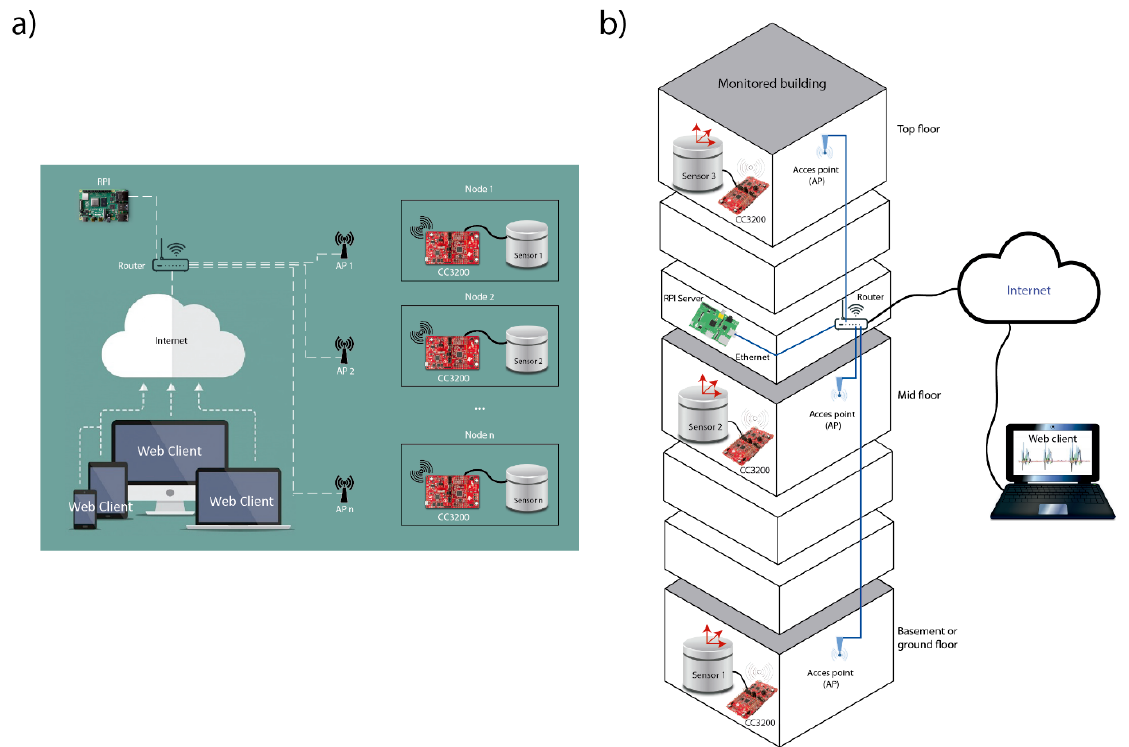
Figure 1. ( a ) General scheme of the developed system and its elements. ( b ) General three-dimensional schematic of a monitored building.